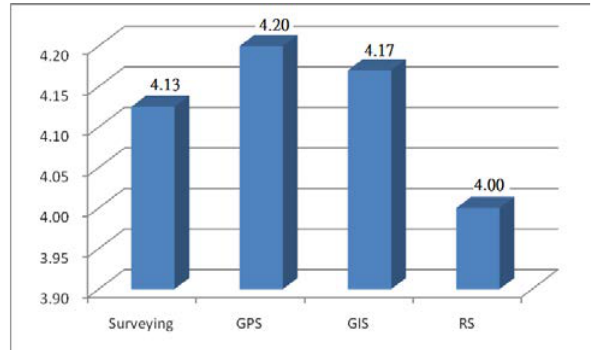
Figure 7. The average votes